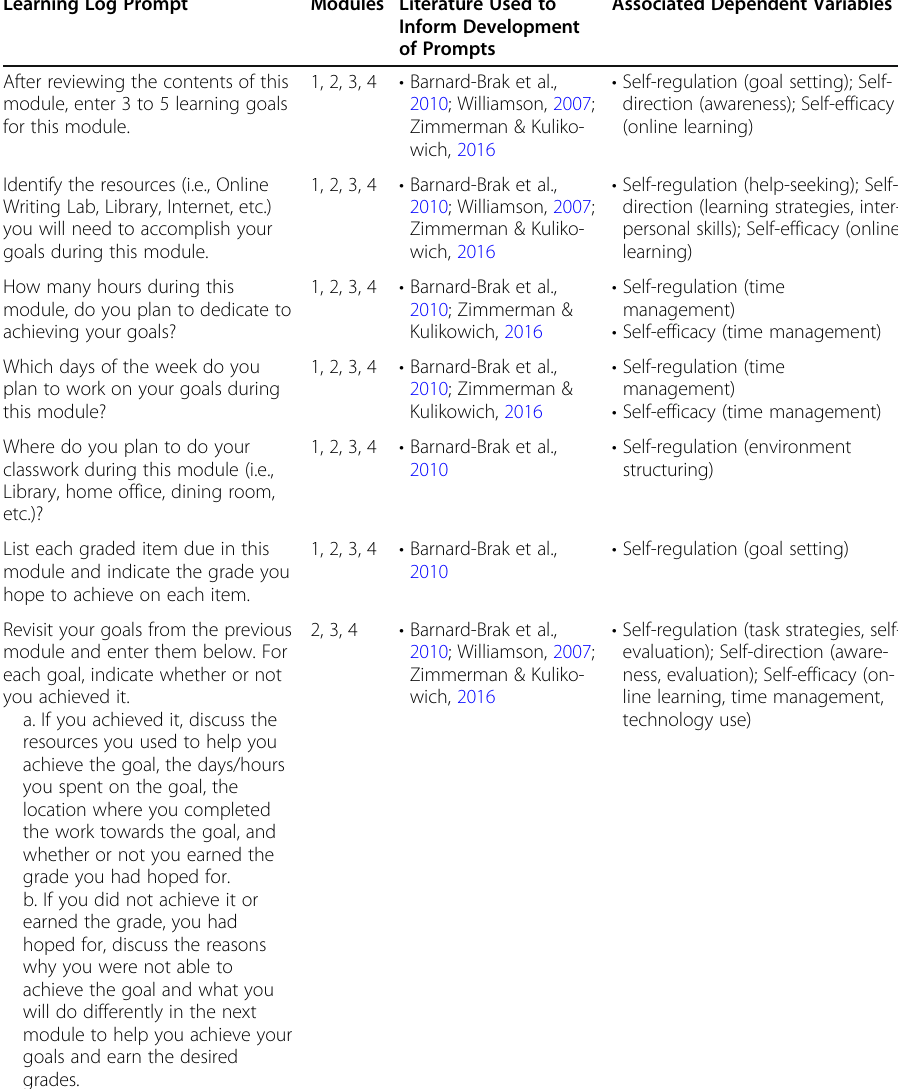
Table 1 Learning log prompts, development of prompts, and their association with self-regulation, self-direction, and online learning self-efficacy Learning Log Prompt Modules Literature Used to Associated Dependent Inform Development of Prompts